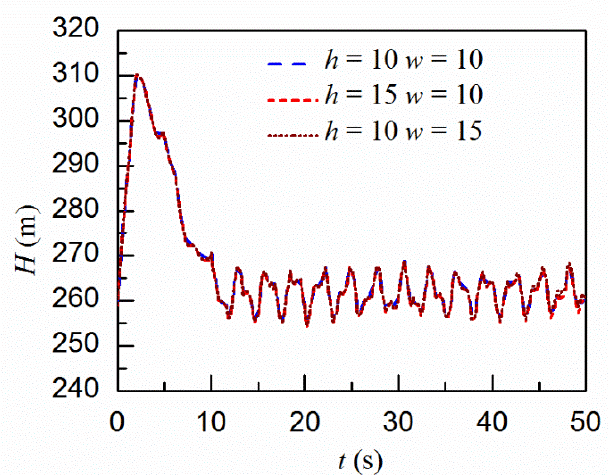
Figure 9. Comparison of the pressure heads at the inlet of the spiral case with different sizes of the sand basin.